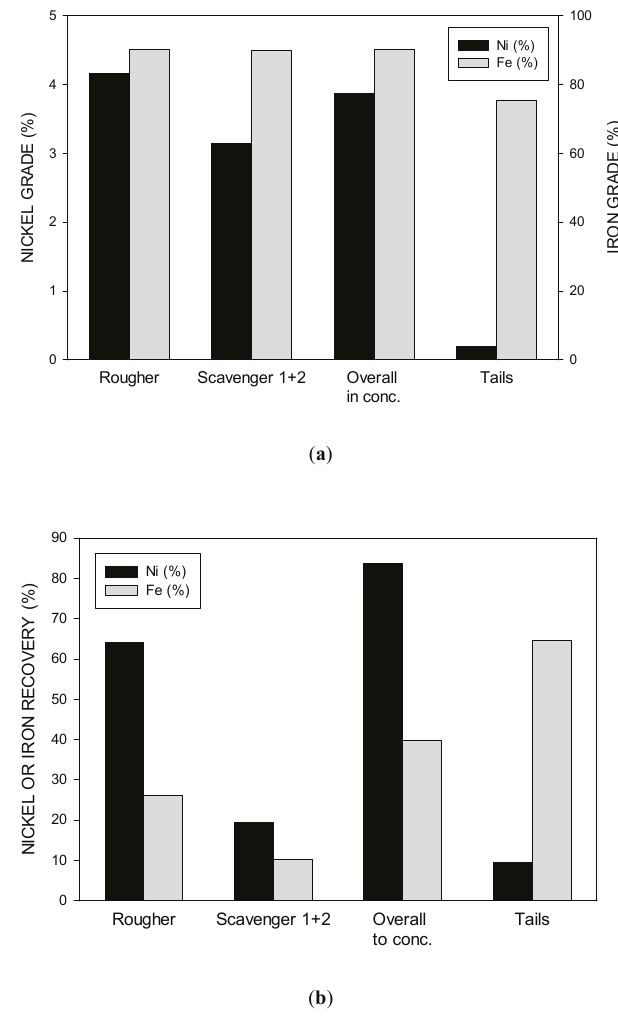
Figure 18. ( a ) Nickel and iron grades in the concentrates and tails for the tube furnace tests; ( b ) Nickel and iron recoveries in the concentrate and tails for the tube furnace tests.